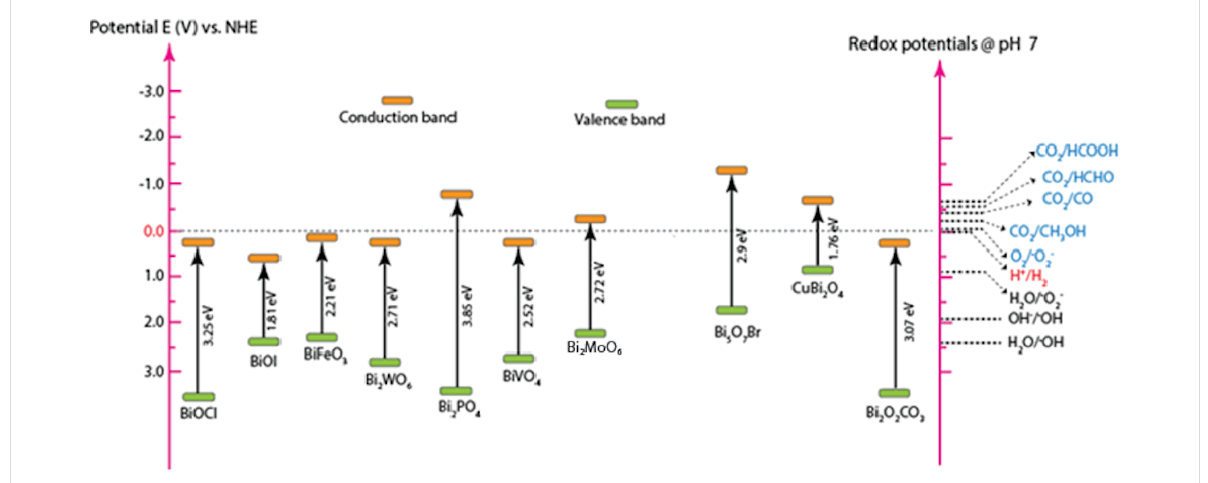
Figure 3: Bandgaps of some bismuth-based photocatalysts extracted from various research articles [27,35-37,83-86].